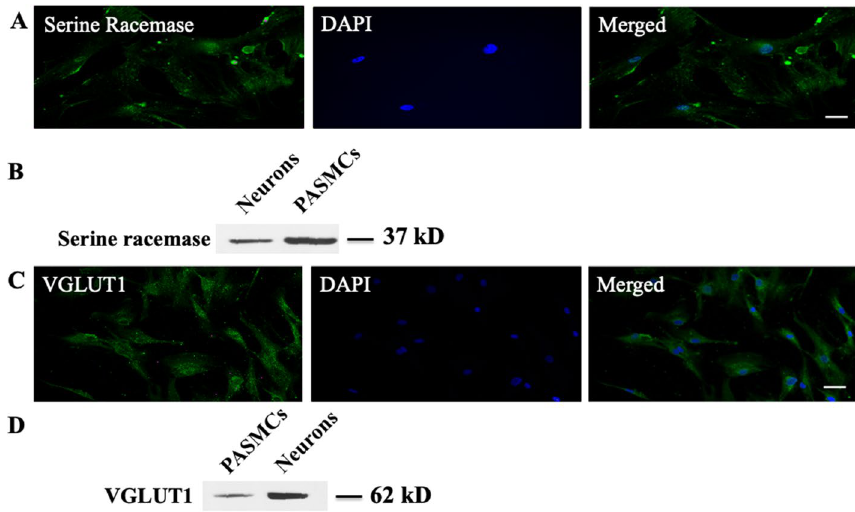
Figure 6. Serine racemase and VGLUT1 expression in HPASMCs. HPASMCs showed positive immunoreactive staining for serine racemase ( A ) and VGLUT1 ( C ), respectively. Immunopositive bands containing serine racemase and VGLUT1 protein were also detected in whole cell lysates from cultured HPASMCs (( B , D ), respectively). Cropped images are shown for conciseness. Full-length blots are represented in Supplementary Fig. S13. Results are representative images taken from at least three separate experiments. Scale bar = 50